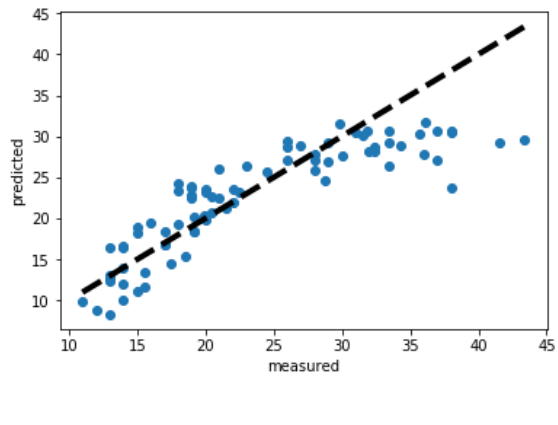
Figure 1. Multiple Linear